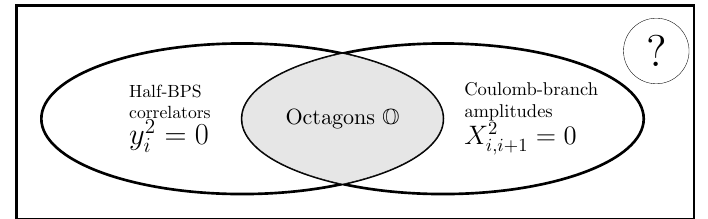
Figure 15 . Half-BPS correlators are labelled by 10D coordinates ( x, y ) where y is a null 6D vector, while Coulomb branch scattering amplitudes are labelled by null-separated 10D points. These intersect on the restricted Coulomb branch, on which the octagons are defined. We can speculate on the existence of generalized correlators which satisfy a full 10D symmetry without any null